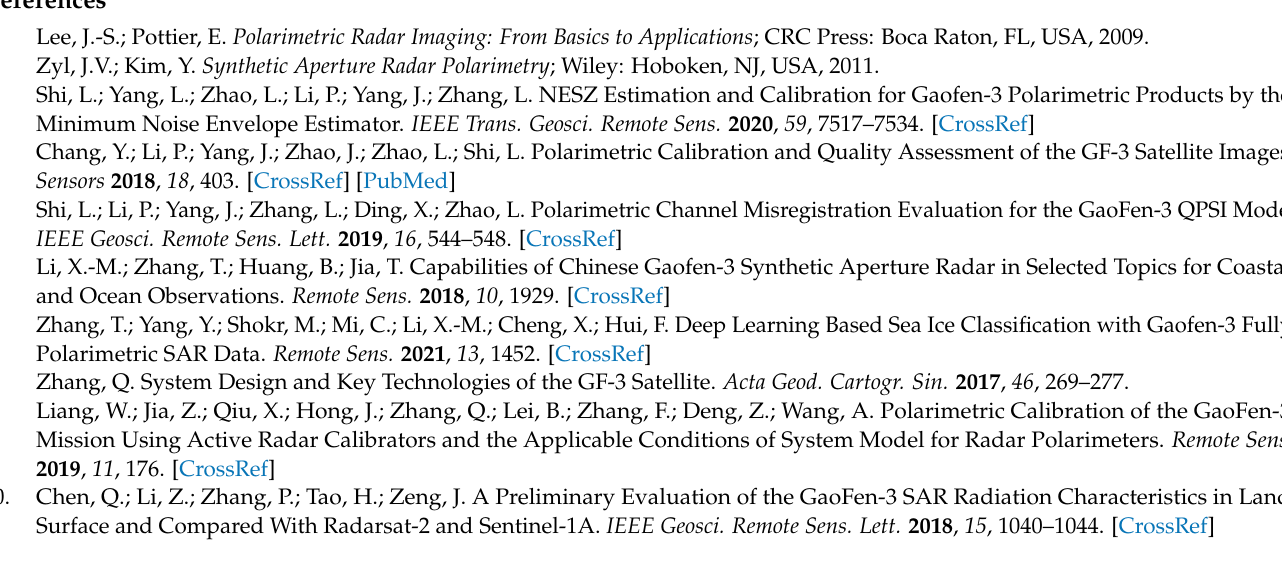
Figure A2. Assessment of the four calibration methods in the different cross-pol channel imbalance amplitudes. Additive noise with an SNR of 25 dB was added for the simulation. ( a – i ) represent the calibration performance when an α amplitude of − 1, 2, and 3 dB was imposed, respectively.